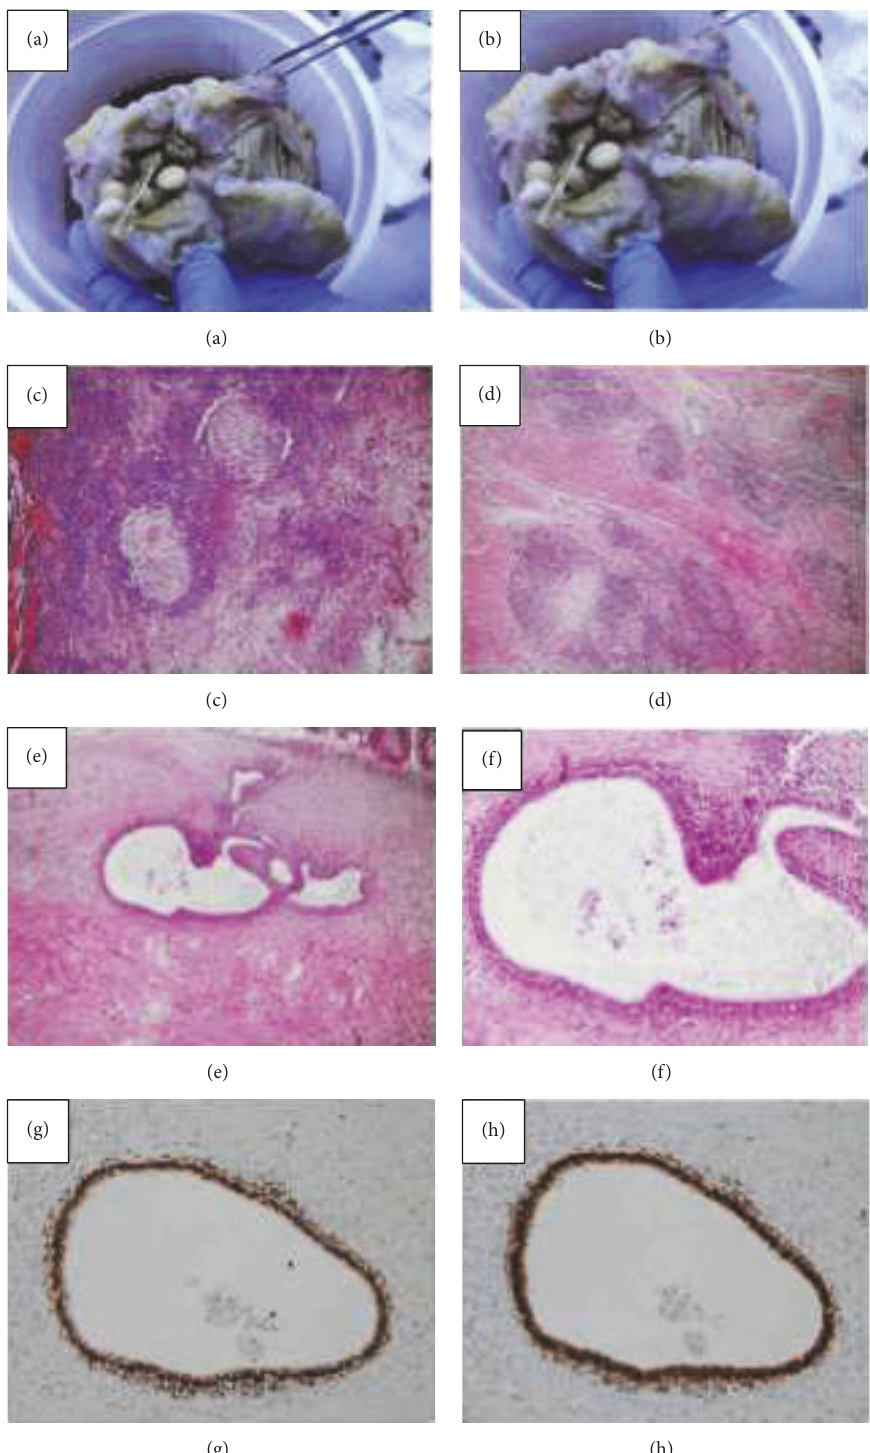
Figure 3: ((a), (b)) Macroscopic features of the specimen with the stenotic area and mesalamine pills accumulation. ((c), (d)) CD with typical granuloma ((c) EE 4 HPF) and lymphoid aggregates ((d) EE 10 HPF). ((e)–(h)) Endometriosis focus ((e) EE 4 HPF; (f) EE 10 HPF) and immunohistochemical staining for estrogen ((g) 10 HPF) and progesterone ((h) 10